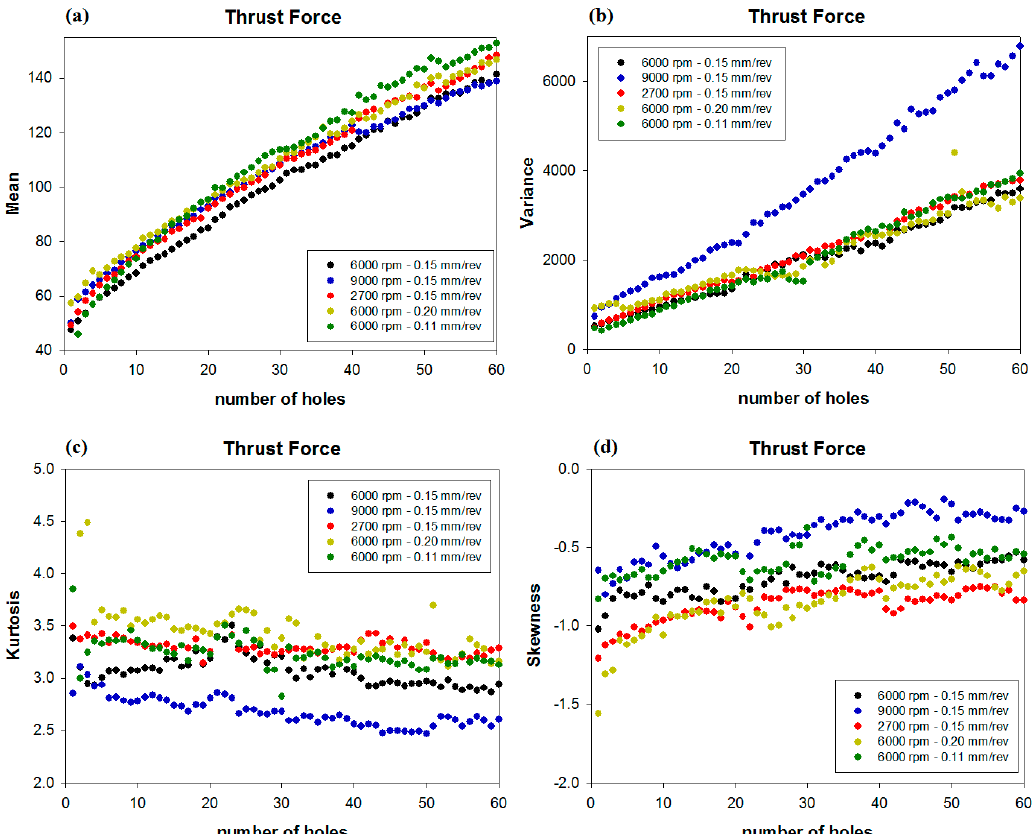
Figure 13. Statistical features extracted from the thrust force signals for all operating conditions vs. hole number: ( a ) arithmetic mean; ( b ) variance; ( c ) kurtosis; ( d ) skewness.